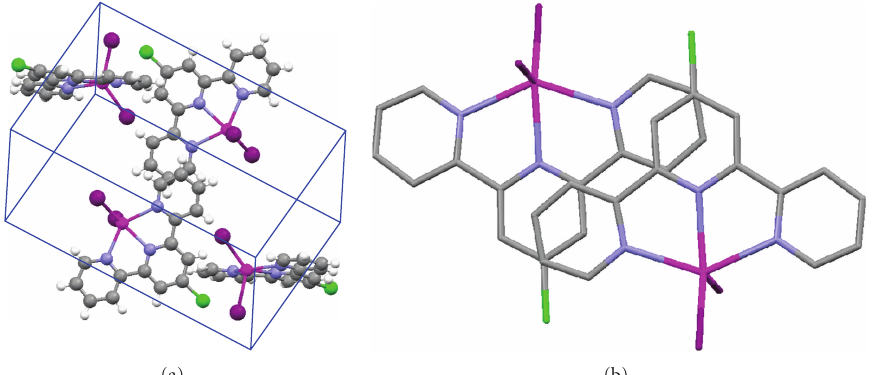
Figure 3: (a) The unit cell of [Cd(Cltpy)I 2 ]. (b) Close-up view of the aromatic π - π contacts showing ligand overlap (slipped face-to-face interaction).